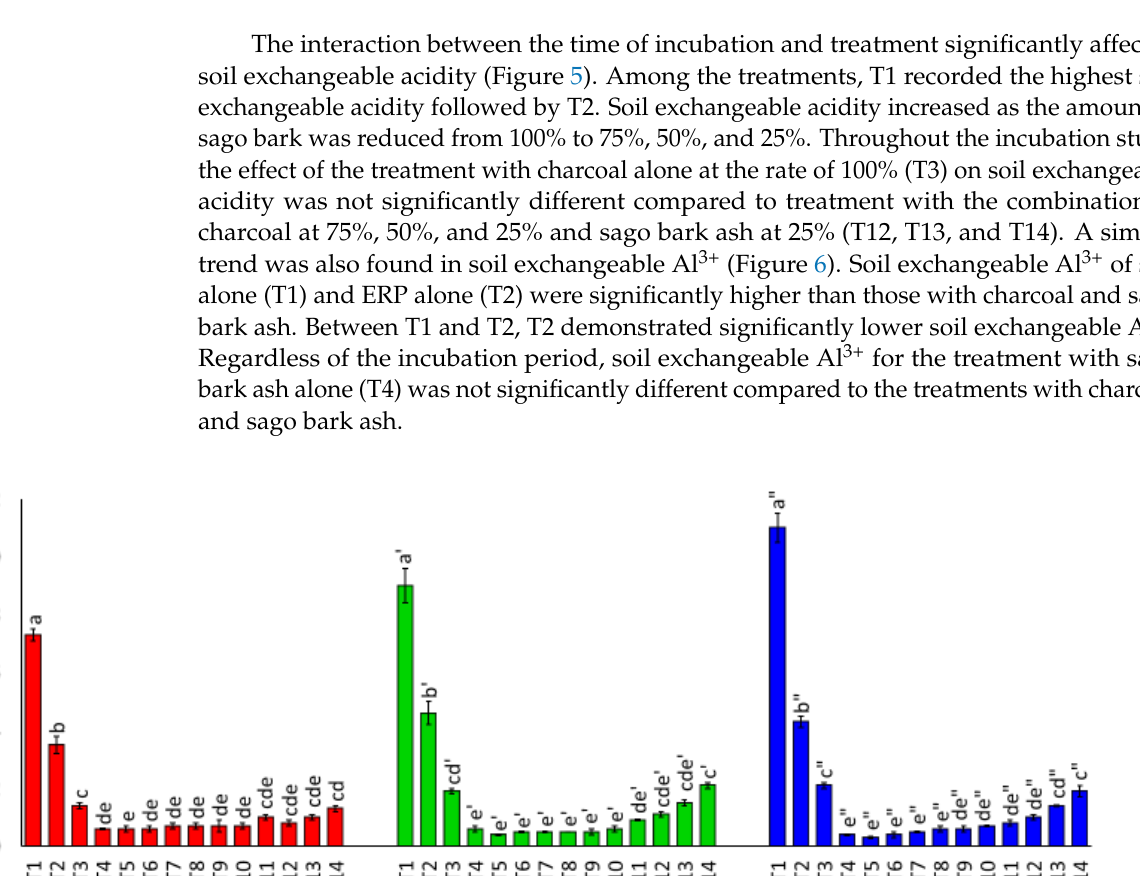
Figure 6. Effects of treatments on soil exchangeable aluminium ions after thirty, sixty, and ninety days of incubation, where T1: soil alone, T2: Egypt rock phosphate alone, T3: Egypt rock phosphate